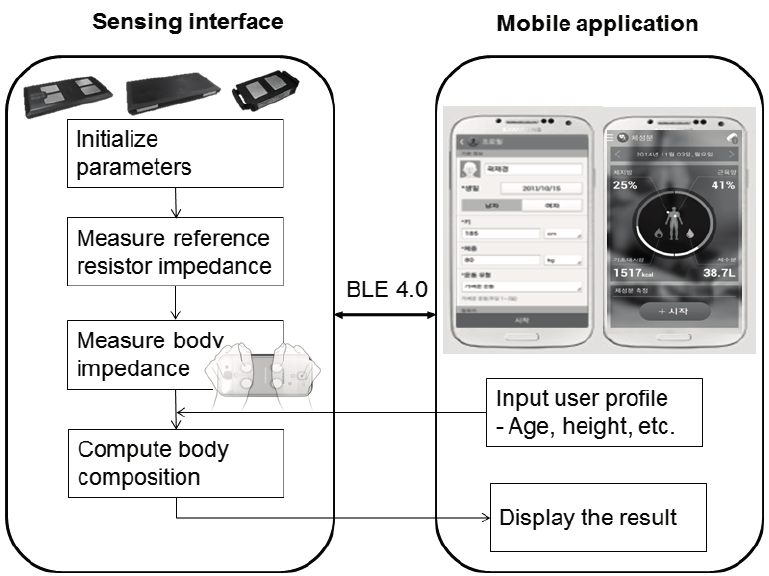
Figure 2. Overall process